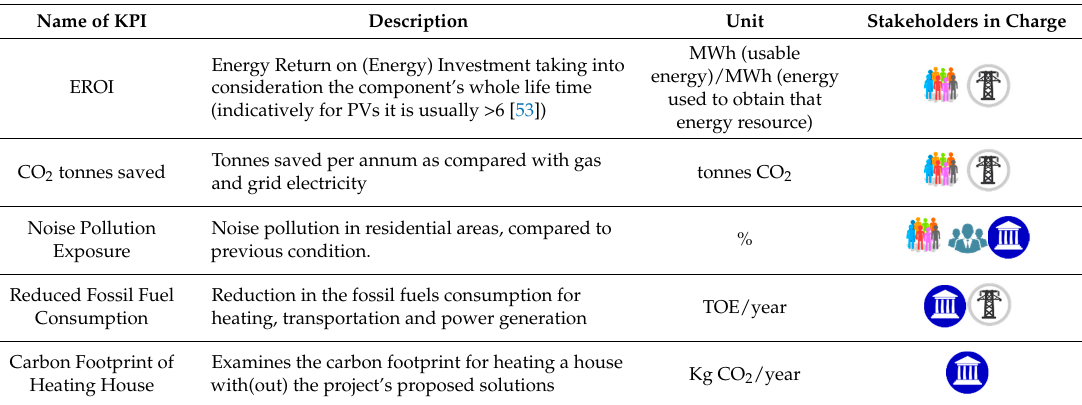
Table 5. List of Environmental KPIs.